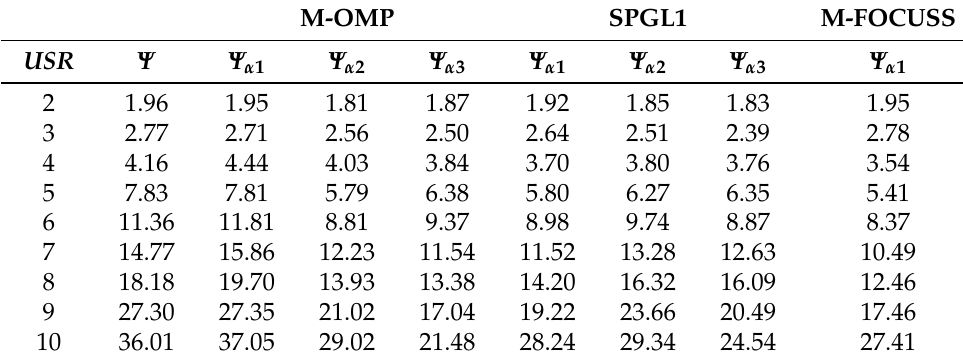
Table 8. Comparison of PRD values from the algorithms using the three dictionary matrices at several USR values, for ECG signal No. 101.